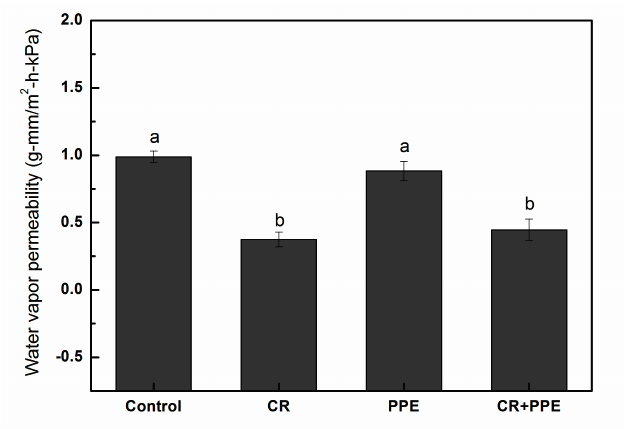
Figure 1. Water vapor permeability for chitosan films incorporated with pomegranate peel extract and carvacrol. Each data is the mean values per treatment and time point (mean ± standard error). Values not sharing a lower case letter are significantly different at p < 0.05. PPE, pomegranate peel extract; CR, carvacrol.